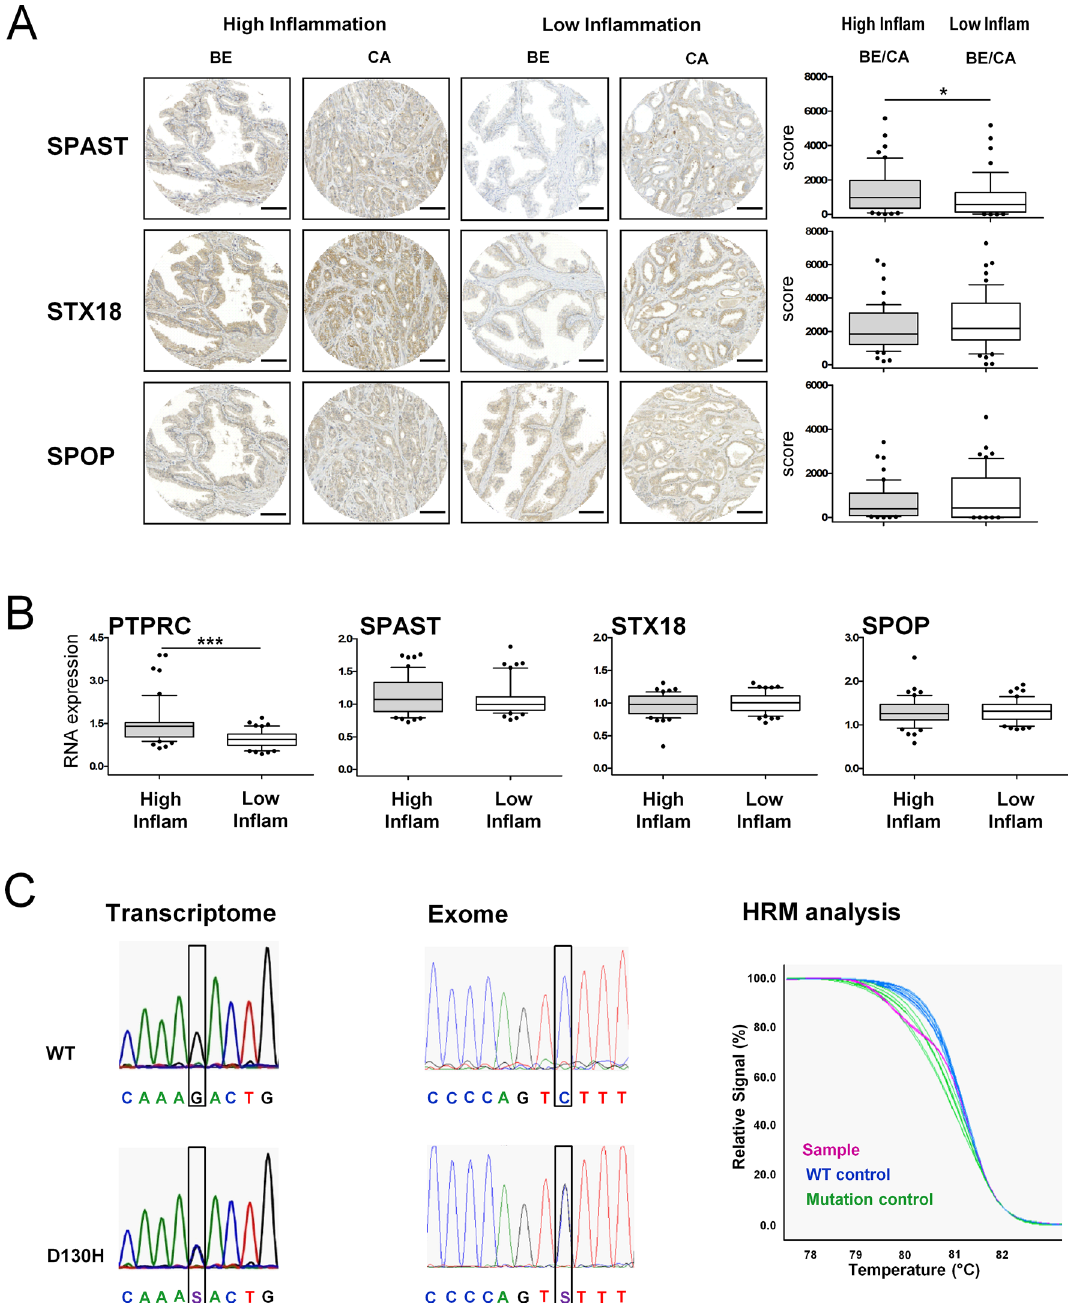
Fig 2. Quantification of corresponding autoantigen levels in prostate tissue. A Immunohistochemical stainings of representative tissue microarray spots from high and low inflammation patient cohorts. SPAST, STX18 and SPOP are expressed in the epithelium of benign (BE) and cancer (CA) areas of both cohorts. Quantitative analysis was performed using the HistoQuest immunohistochemistry analysis software (TissueGnostics). A score was calculated by multiplying staining intensity and percentage of positively stained cells. n = 25 per group. * P < 0.05, Mann-Whitney Test. Bar, 100 μ m. B Quantification of the pan-lymphocyte marker CD45 (PTPRC) and autoantigen mRNA levels in high and low inflammation patient groups. n = 25 per group. *** P < 0.001, Mann-Whitney Test. C Electropherograms of transcriptome (5 ’ -3 ’ ) and exome (3 ’ -5 ’ ) sequencing results depicting wild-type and D130H SPOP mutation sequences. High resolution melting curves for mutated and wild-type DNA: The purple melting curve of the sample consists of 50% mutant and 50% wild-type DNA.